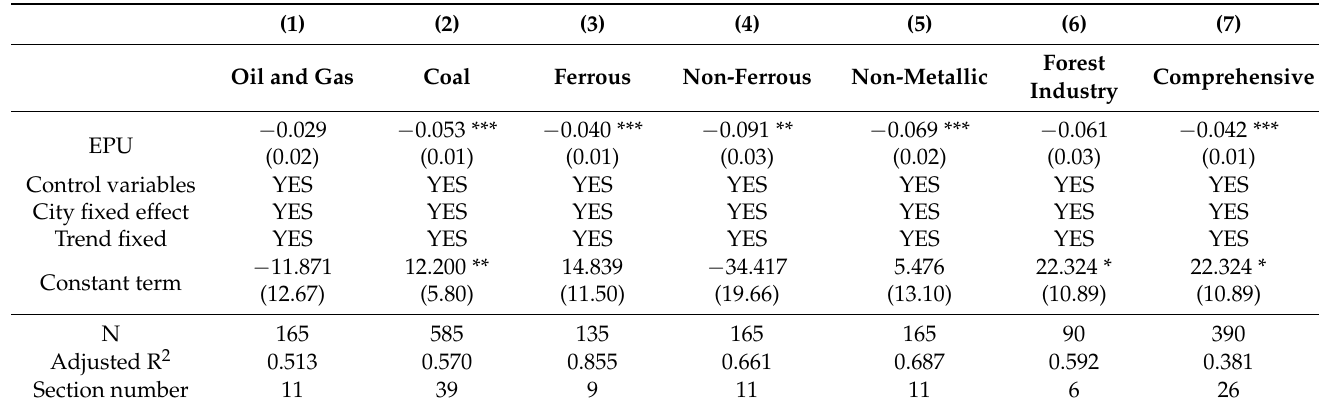
Table 9. Resource-based city (different dominant